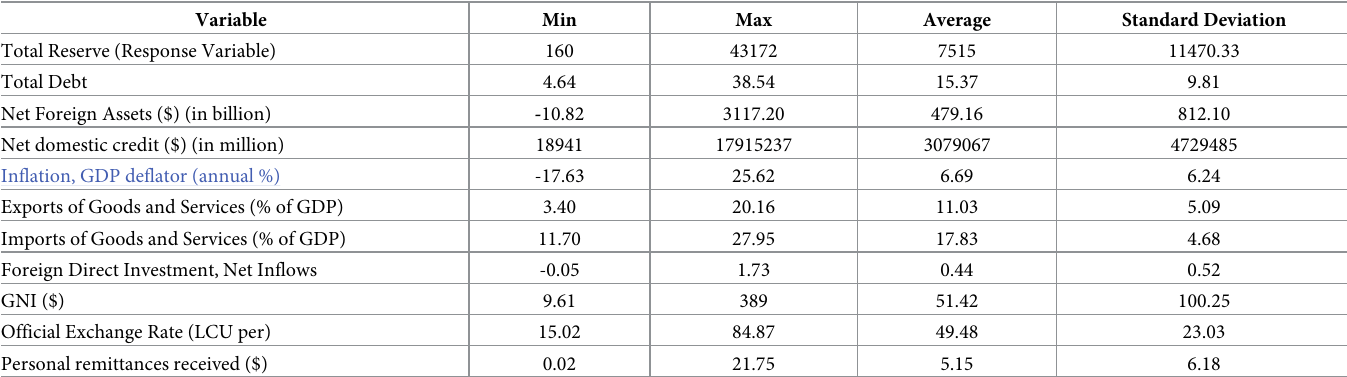
Table 1. Descriptive statistics of the variables included in the